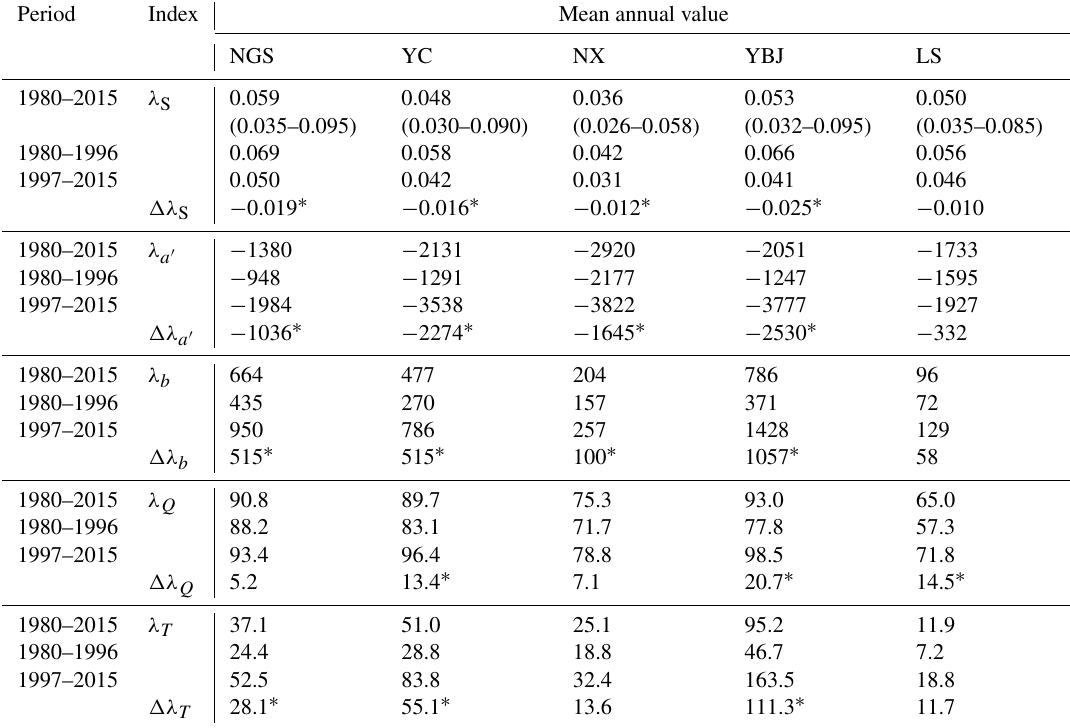
Figure 8. Relationship of S and Q at different values of K (a) and m (b) and combinations of K and m (c) in the two periods for subbasin YC. The different set of numbers in the blue box with a dashed line in each panel shows the K and m values and therefore the different S – Q relationships in the recent warmer period. Table 4. The storage sensitivity of discharge ( λ S ; mm − 1 ) and sensitivity coefficients of recession parameters of a (cid:48) ( λ a (cid:48) ) and b ( λ b ), T ( λ T ), and Q ( λ Q ) to storage changes ( (cid:49)S) during different periods for each subbasin. The values in parentheses refer to the range of annual value.